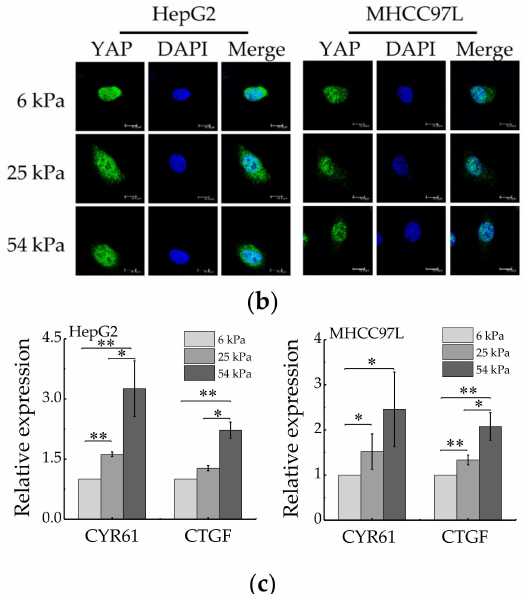
Figure 4. YAP activity is regulated by ECM sti ff ness. ( a ) Western blot analysis of total YAP and p-YAP protein levels in HepG2 and MHCC97L cells cultured on di ff erent sti ff ness of hydrogel for 48 h ( n = 3, * p < 0.05, ** p < 0.01). ( b ) qRT-PCR analysis of indicated genes mRNA levels in HepG2 and MHCC97L cells ( n = 3, * p < 0.05, ** p < 0.01). ( c ) Confocal immunofluorescence images of YAP in HepG2